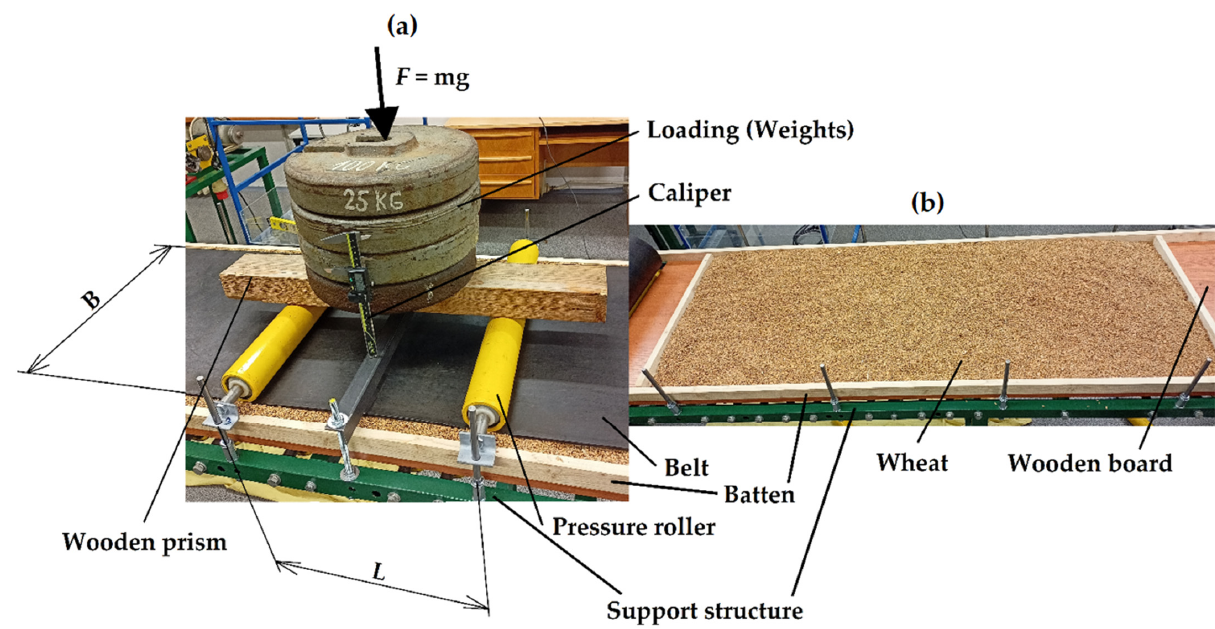
Figure 5. ( a ) Measurement of deflection in the middle between rollers. ( b ) Even distribution of wheat.